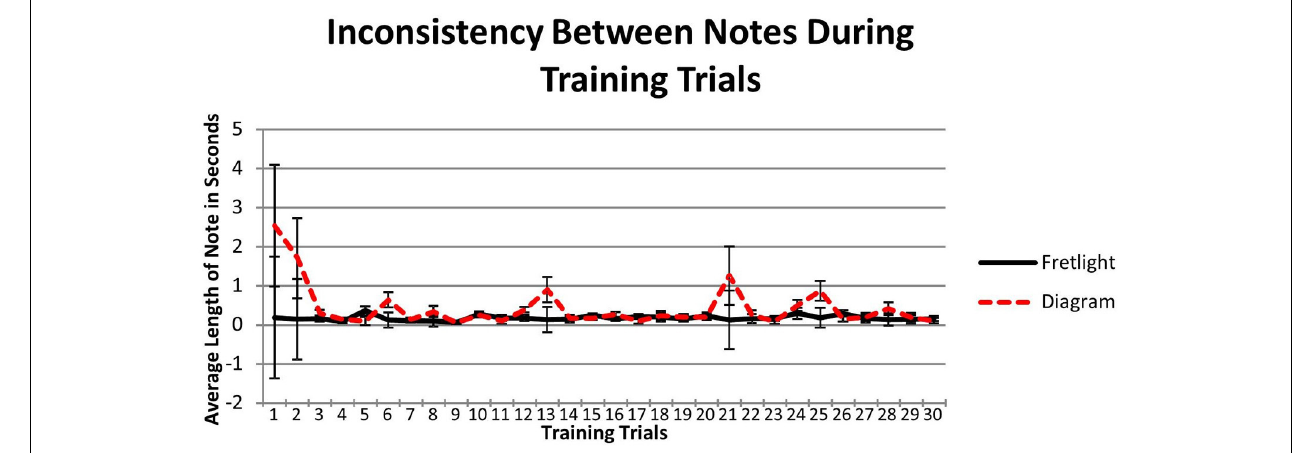
FIGURE 7 | Inconsistency between notes during training trials for Experiment 2.